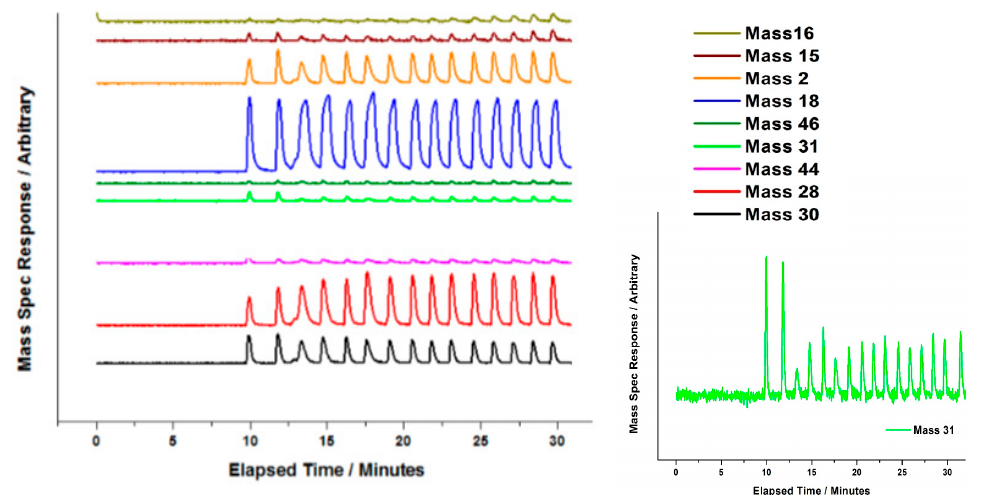
Figure 25. Pulse flow data for Fe 2 (MoO 4 ) 3 , Mo:Fe 1.5:1, under anaerobic conditions. MeOH pulsing was applied to the catalyst under He at 350 °C. The mass 31 data is expanded in the inset.